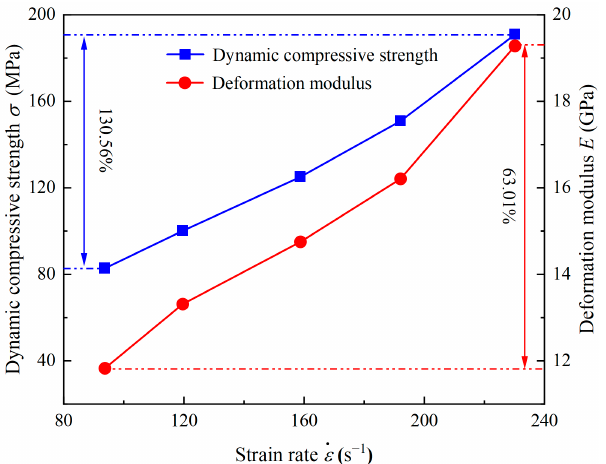
Figure 14. Variation in dynamic strength and the deformation modulus of sandstone with strain